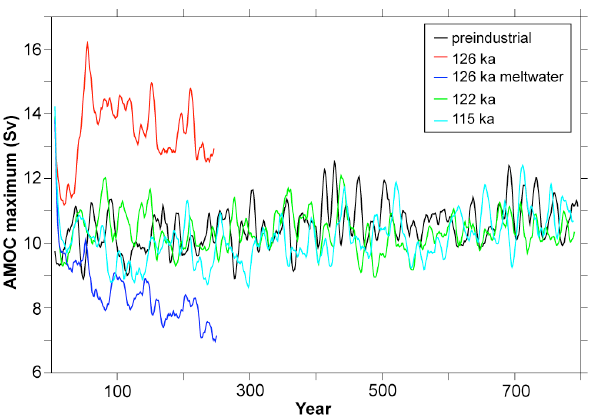
Figure 3: Maximum of the Atlantic meridional overturning streamfunction (1 Sv = 10 6 m 3 /s) 2 Fig. 3. Maximum of the Atlantic meridional overturning stream- taken from 500 m to the bottom for all simulations: preindustrial (black), 126 ka (red), 126 ka 3 meltwater (blue), 122 ka (green) and 115 ka (turquoise). 4 function (1Sv=10 6 m 3 s − 1 ) taken from 500m to the bottom for all 5 simulations: preindustrial (black), 126ka (red), 126ka meltwater (blue), 122ka (green) and 115ka